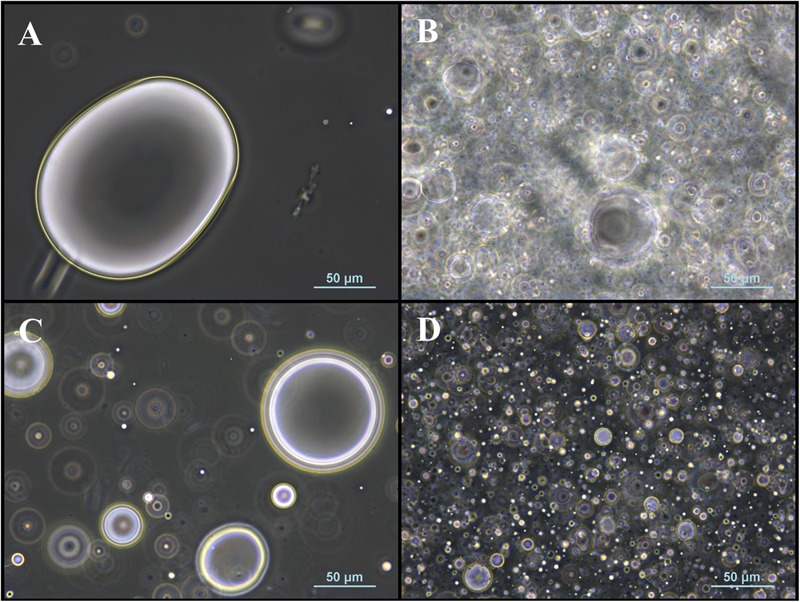
Microscopic pictures of untreated and sonicated fatty acid-DES emulsions. (A) Untreated fatty acid-ChCl:Glc emulsion, (B) sonicated fatty acid-ChCl:Glc emulsion, (C) untreated fatty acid-ChCl:U emulsion, and (D) sonicated fatty acid-ChCl:U emulsion. Fatty acid concentration in all fatty acid-DES emulsion was 0.5 mmol/mL. The images were obtained using phase contrast and a Nikon Eclipse E200 microscope.